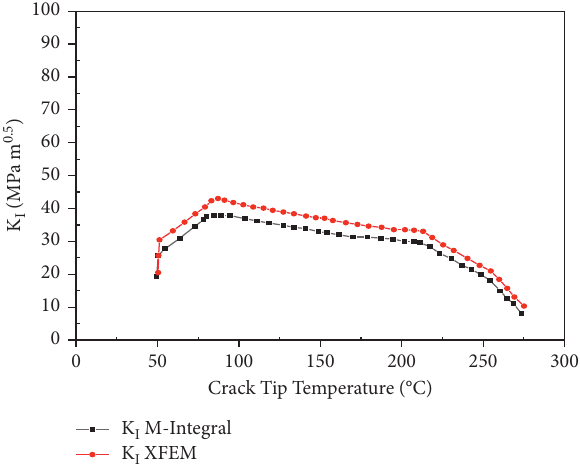
Figure 16: Axial and hoop stress distribution at the maximal stress location in the RPV model during the AOO transient.